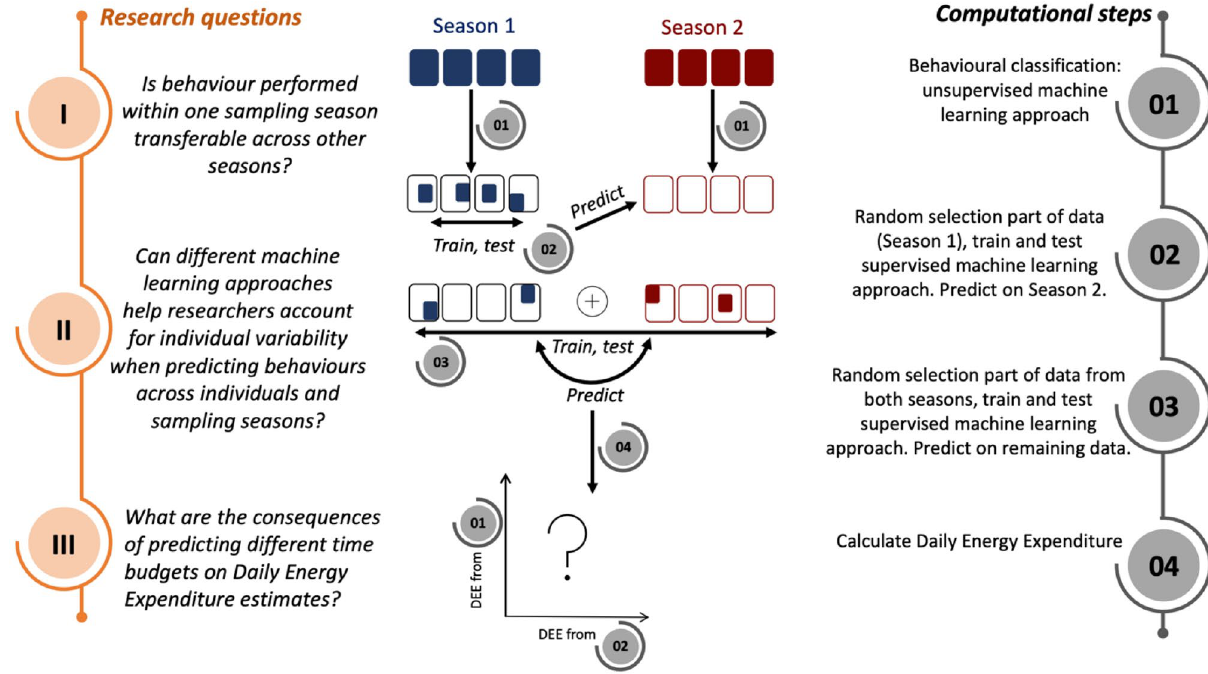
Figure 1. Conceptual overview of research questions and approach followed in this study. Both unsupervised and supervised machine learning approaches are applied on large accelerometer datasets to detect and predict behavioural activities. We quantify the behavioural variation included in the training datasets used for the supervised approach and test their predictive performance. We finally validate DEE estimates resulted from the behavioural activity budgets from the two approaches based on energetic validation obtained on Adélie penguin ( Pygoscelis adeliae) from Hicks et al. 32